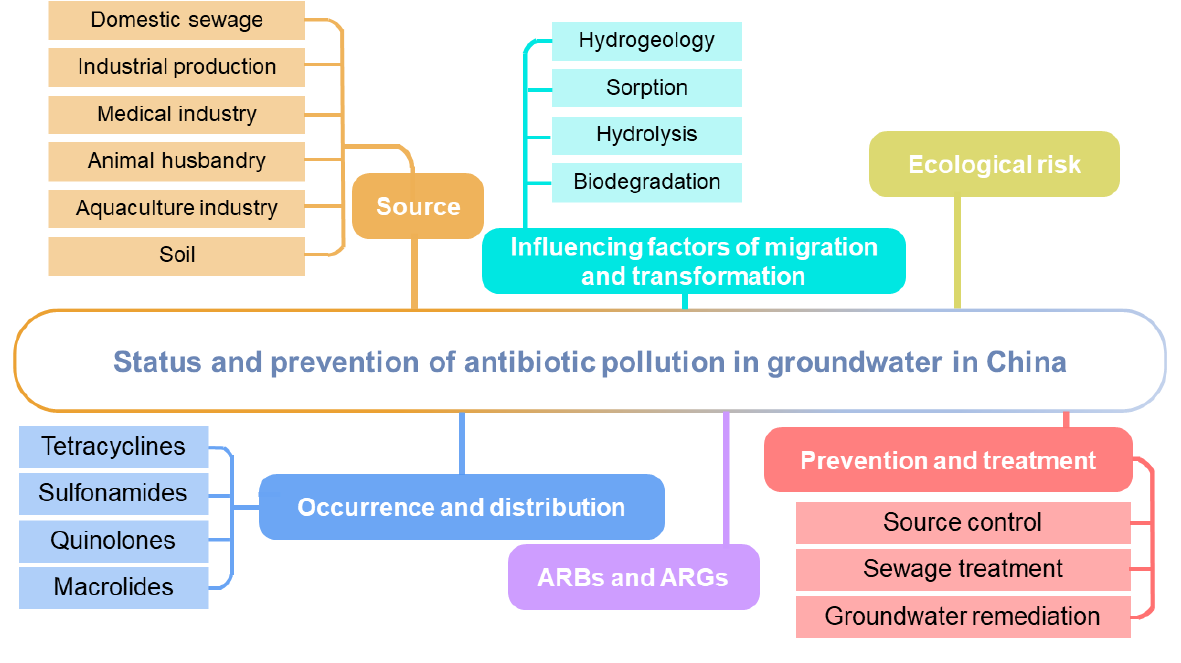
Figure 1. Overview of the framework.